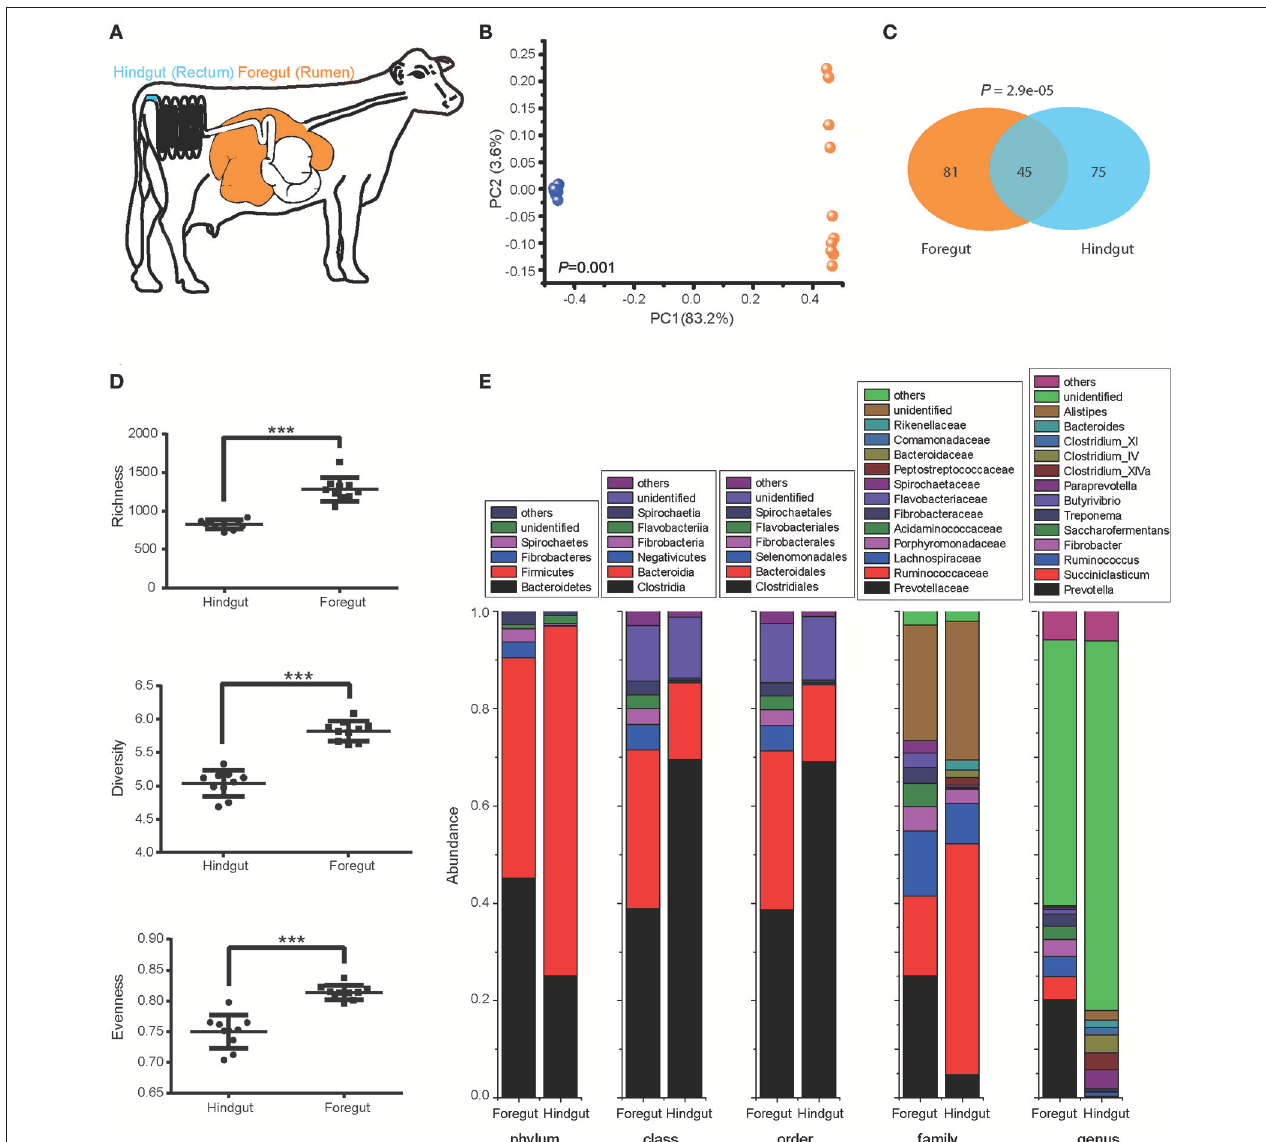
FIGURE 1 | Foregut (rumen) and hindgut (rectum) harbored distinct microbiota. (A) Location of foregut and hindgut in gastrointestinal tract of lactating cow. (B) The microbiota in foregut and hindgut. Plot was drawn on the first two dimension of PCoA based on Bray-Curtis distance; statistical comparison of foregut and hindgut microbiota was performed with ANOSIM analysis. (C) High-confidence OTUs distribution in foregut and hindgut. Venn diagram showed the shared and unique high-confidence OTUs in foregut and hindgut, statistical comparison was performed with hypergeometric test. (D) Richness, diversity and evenness of microbiota in foregut and hindgut. (E) Microbiota community in foregut and hindgut at different levels of taxonomy; only taxa with abundance higher than 1% were shown. Data are expressed as mean ± s.d. *** P <